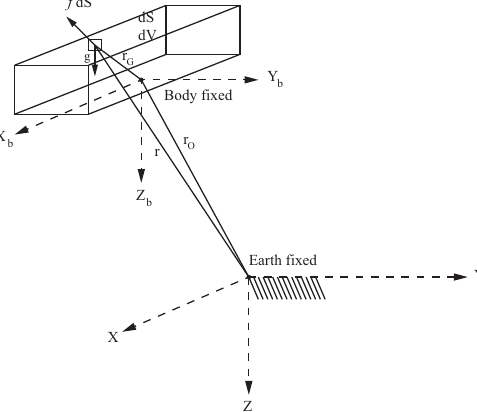
Figure 1. Earth fixed and body fixed